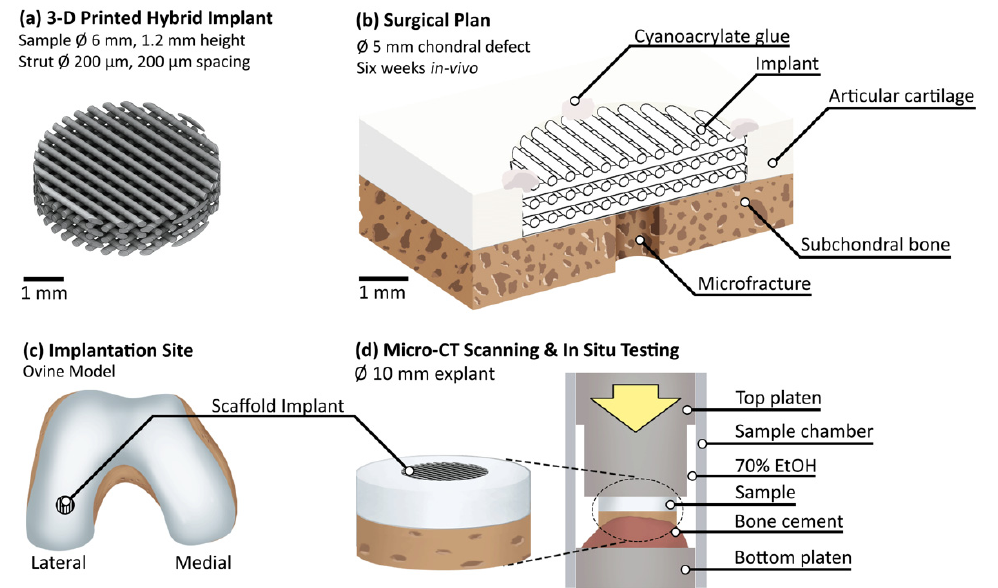
Figure 1. Schematics for each component of this ovine model study: ( a ) hybrid 3D printed scaffold implant design; ( b ) cross-section through surgical procedure plan, with the implant sitting within a chondral defect on top of the subchondral bone, with microfracture providing nutrient delivery and secured with cyanoacrylate glue at four points around the perimeter; ( c ) implantation site in the lateral condyle in a mature female sheep; ( d ) the extracted sample composed of the integrated hybrid implant–cartilage–bone system underwent in situ compression testing during micro-CT scanning.